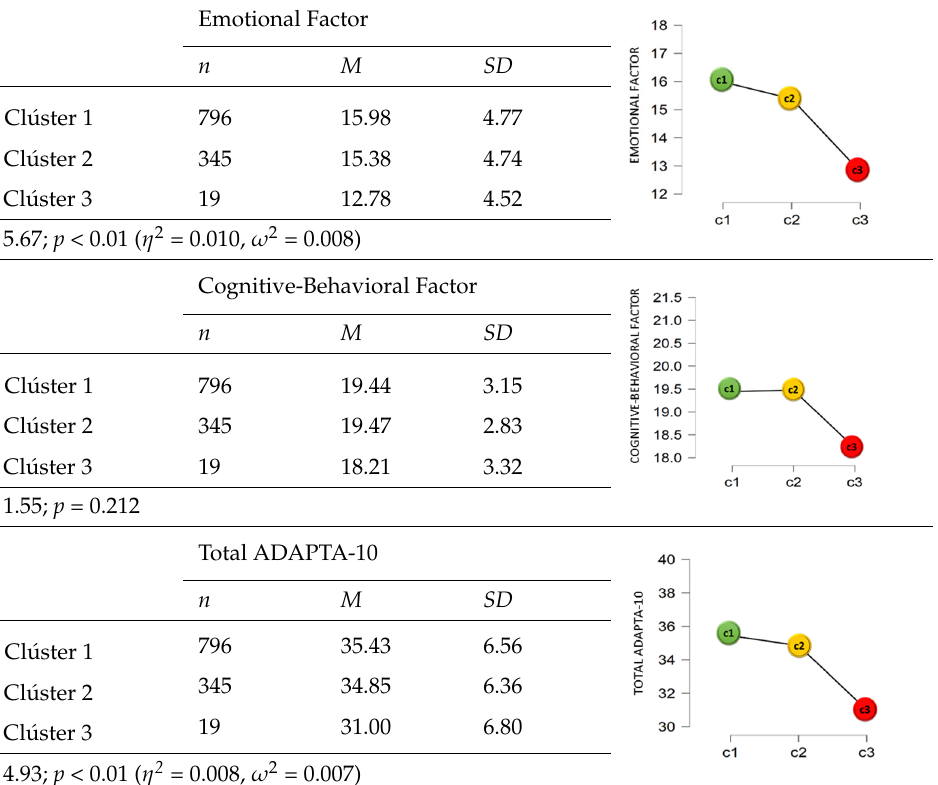
Table 1. Adaptation to change by a COVID-19 cluster, descriptive statistics, and ANOVA. Emotional